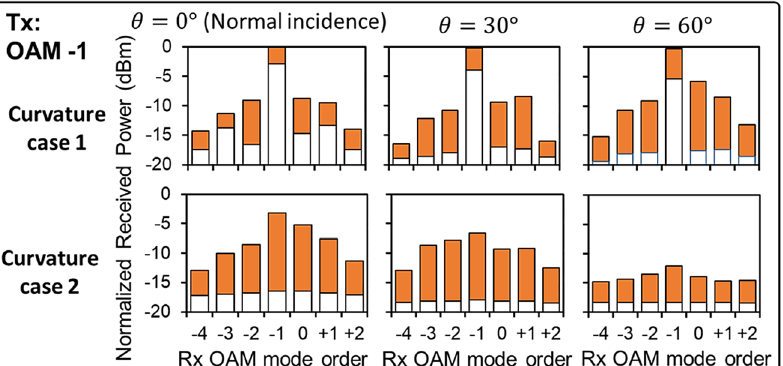
Figure 7: The received power on the transmitted mode and power coupling